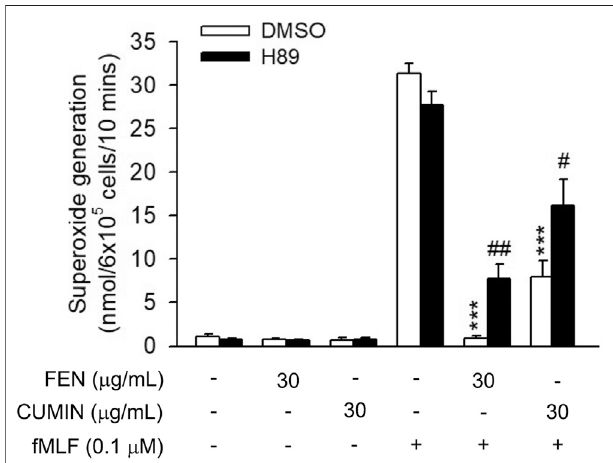
FIGURE 5 | Effects of PKA inhibitor H89 on FEN- and CUMIN-caused inhibition of superoxide generation in human neutrophils. H89 (3 μ M) were preincubated for 5 min before the addition of fennel (FEN) or cumin (CUMIN) volatileoils(30 μ g/ml).SuperoxidegenerationwasinducedbyFMLP/CB and measured using SOD-inhibitable cytochrome c reduction (details in Measurement of Superoxide Generation ). *** p < 0.001 compared with the